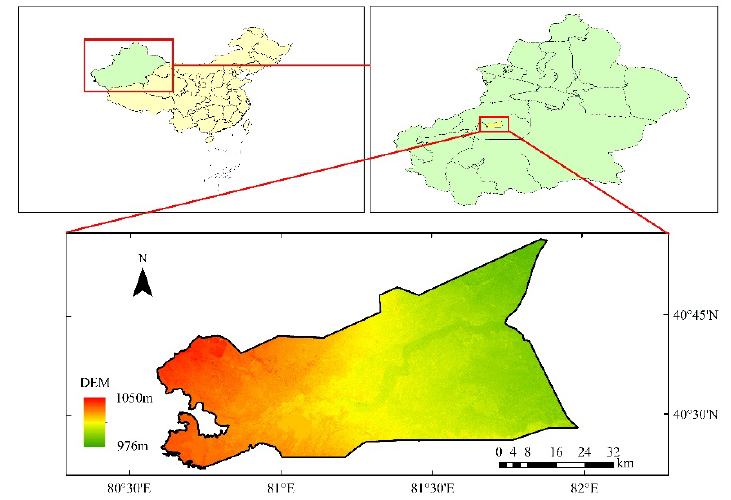
Figure 1. Map of the study